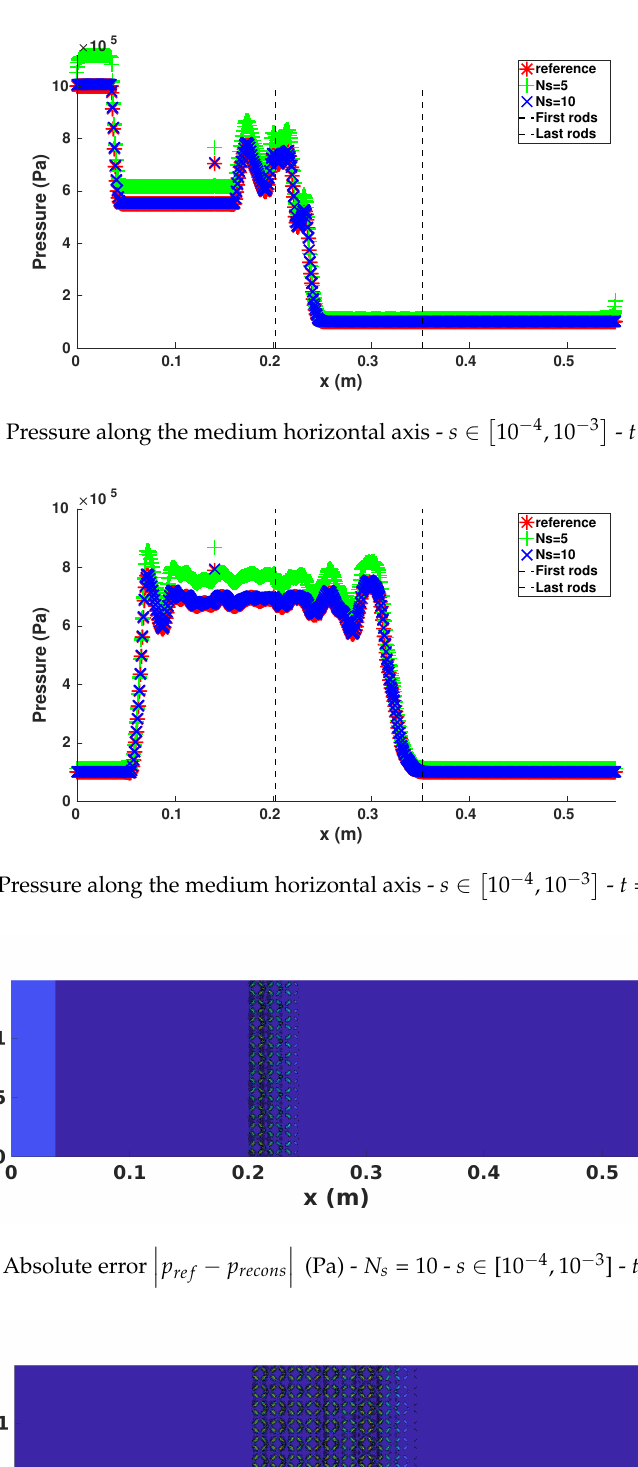
∈ [10 − 4 , 10 − 3 ] - t = 1.6 × 10 − 4